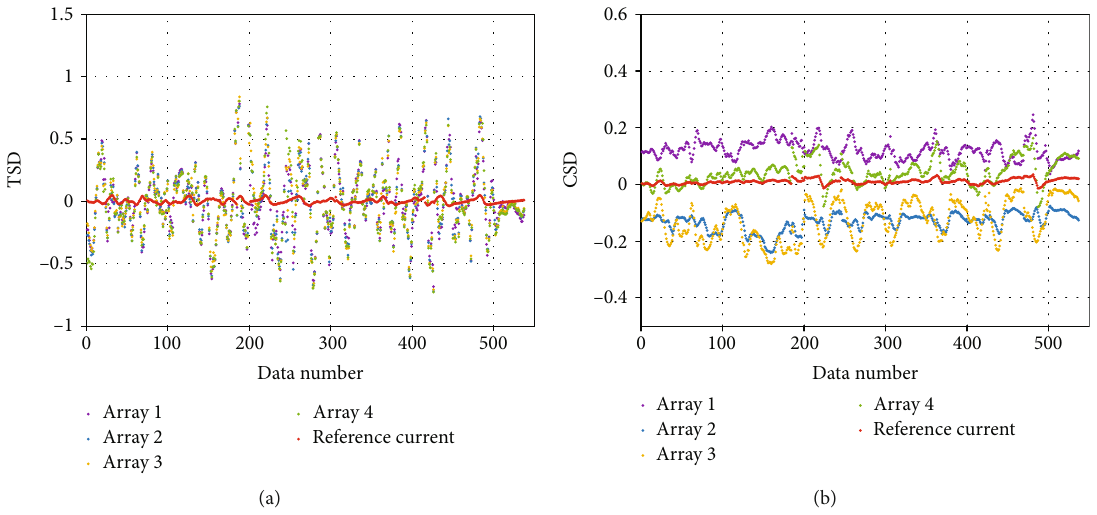
Figure 4: The TSD and CSD distributions of the array current. (a) The distribution of TSD. (b) The distribution of CSD.